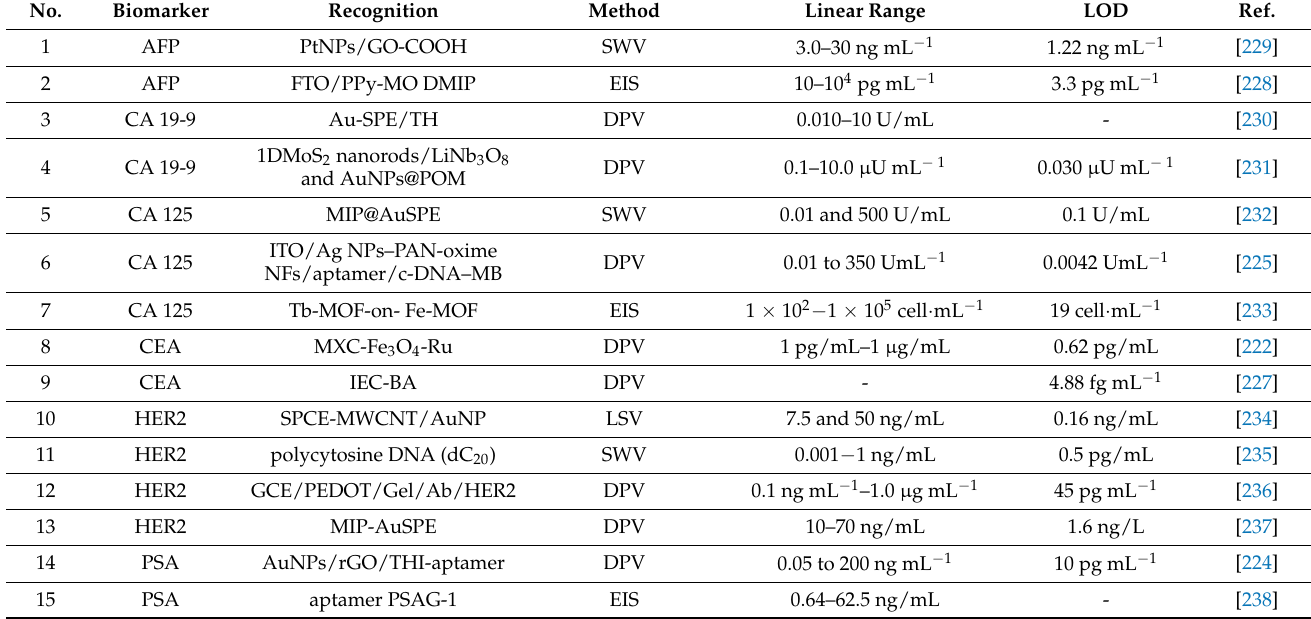
Table 3. Electrochemical sensing methodologies for cancer biomarker detection.